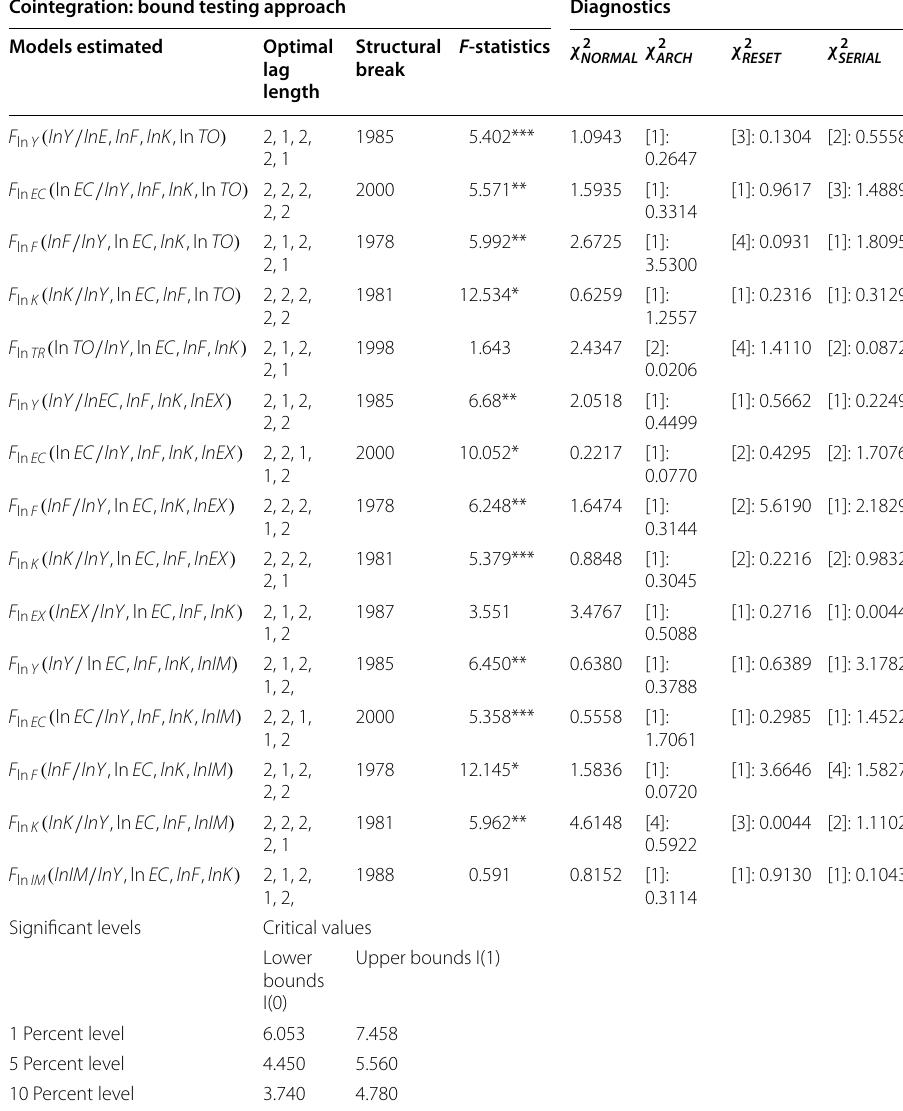
Table 4 ARDL cointegration test